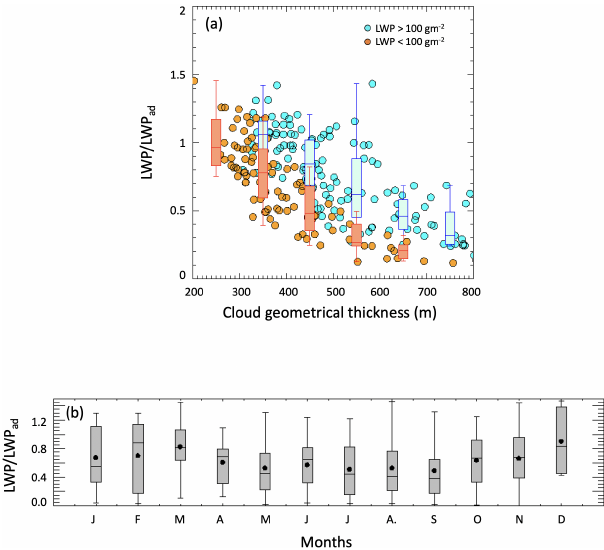
Figure A2. (a) Adiabaticity of sampled clouds against geometri- cal thickness for cloud with 50 < LWP < 100gm − 2 (orange) and > 100gm − 2 (cyan). (b) Annual cycle of adiabaticity. Table A1. Adiabaticity of sampled clouds and geometrical thick- ness ( H ). LWP ad is the liquid water path calculated using the adia- batic